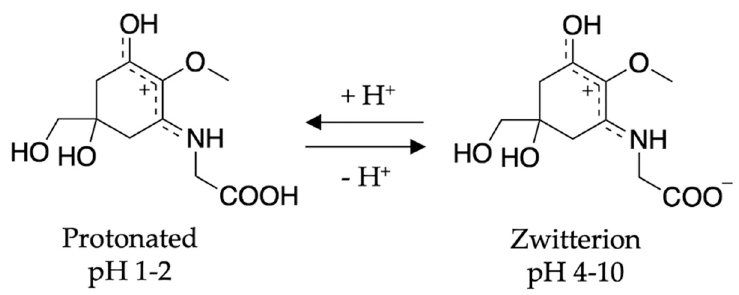
Figure 13. Structure of mycosporine-glycine at di ff erent pHs determined by Matsuyama et al. [129] .